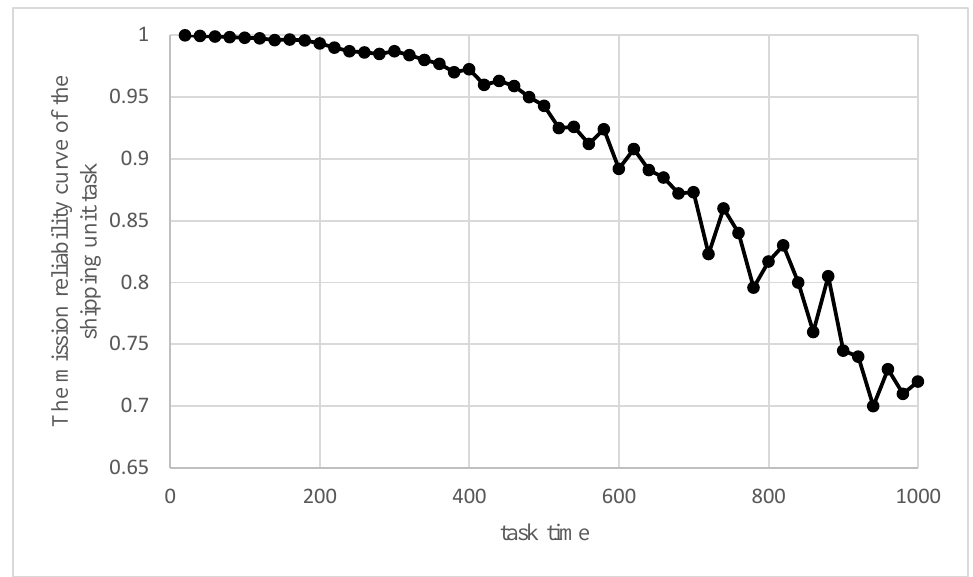
Figure 16. The mission reliability curve of the shipping unit task varies with the task time. Considering the scenario where the task time and allowed delay time are allowed to change simultaneously, the task time is set from 20 to 1000, and the allowed delay time is set from 1 to 10. The 3D curve graph is shown in Figure 17.